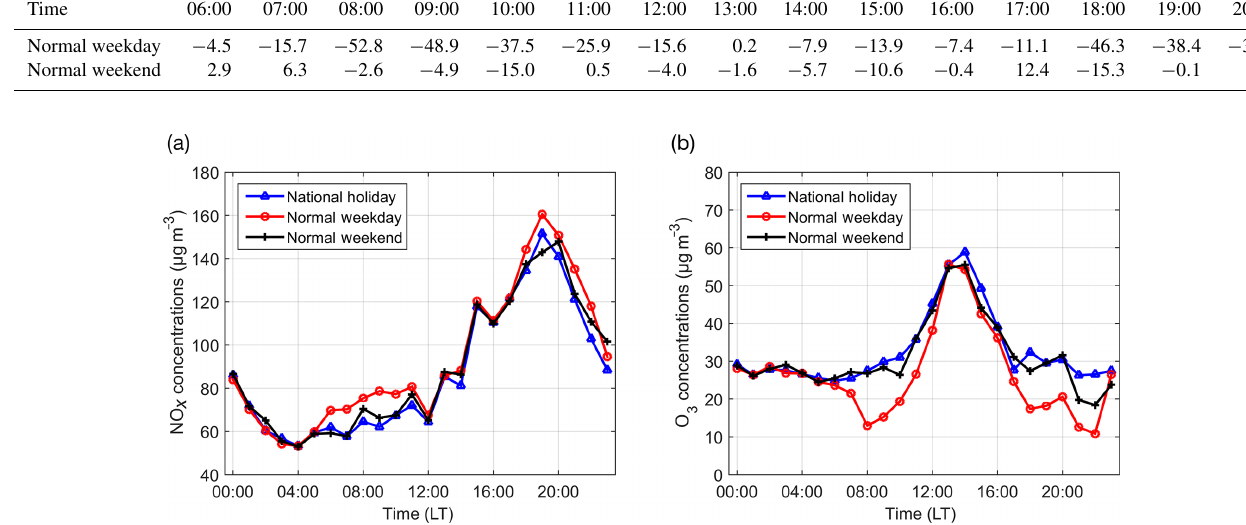
Figure 14. The (a) NO x and (b) O 3 diurnal variation in different sensitivity cases in the simulation street